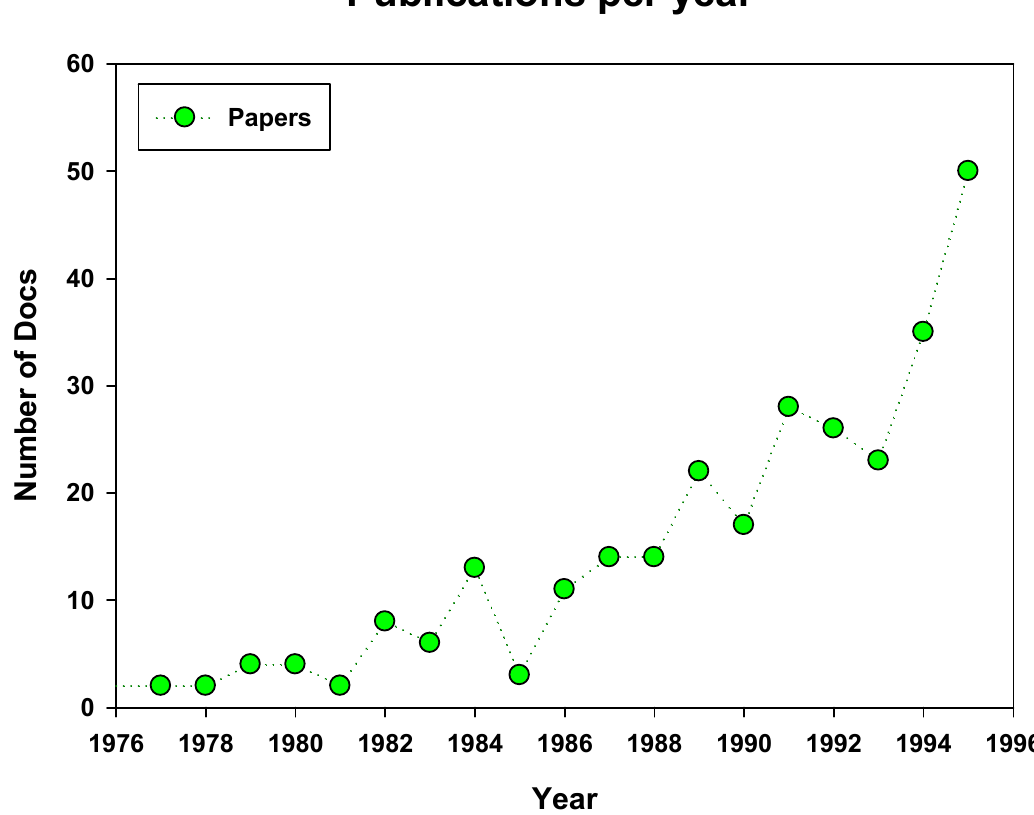
Figure 1. Spanish based membrane publications in international journals from 1970 to 1995.